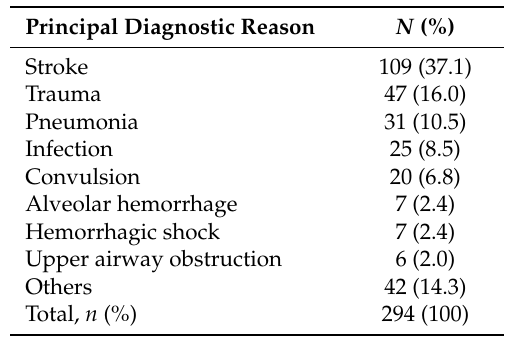
Figure 2. Patient flow in this study. Table 1. Principal diagnostic reasons for tracheal intubation in the study subjects.